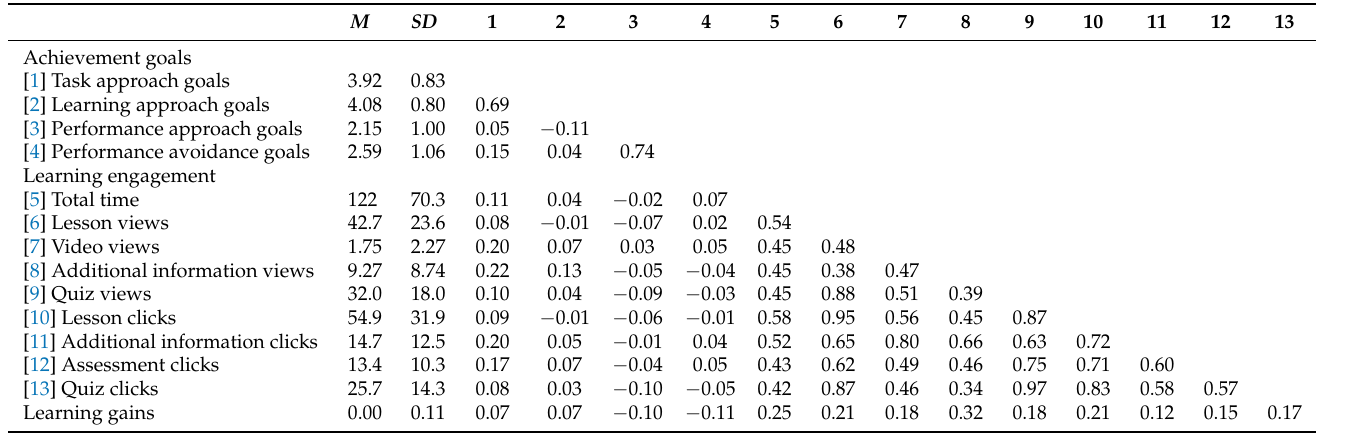
Table 1. Descriptive Statistics and Bivariate Correlations.